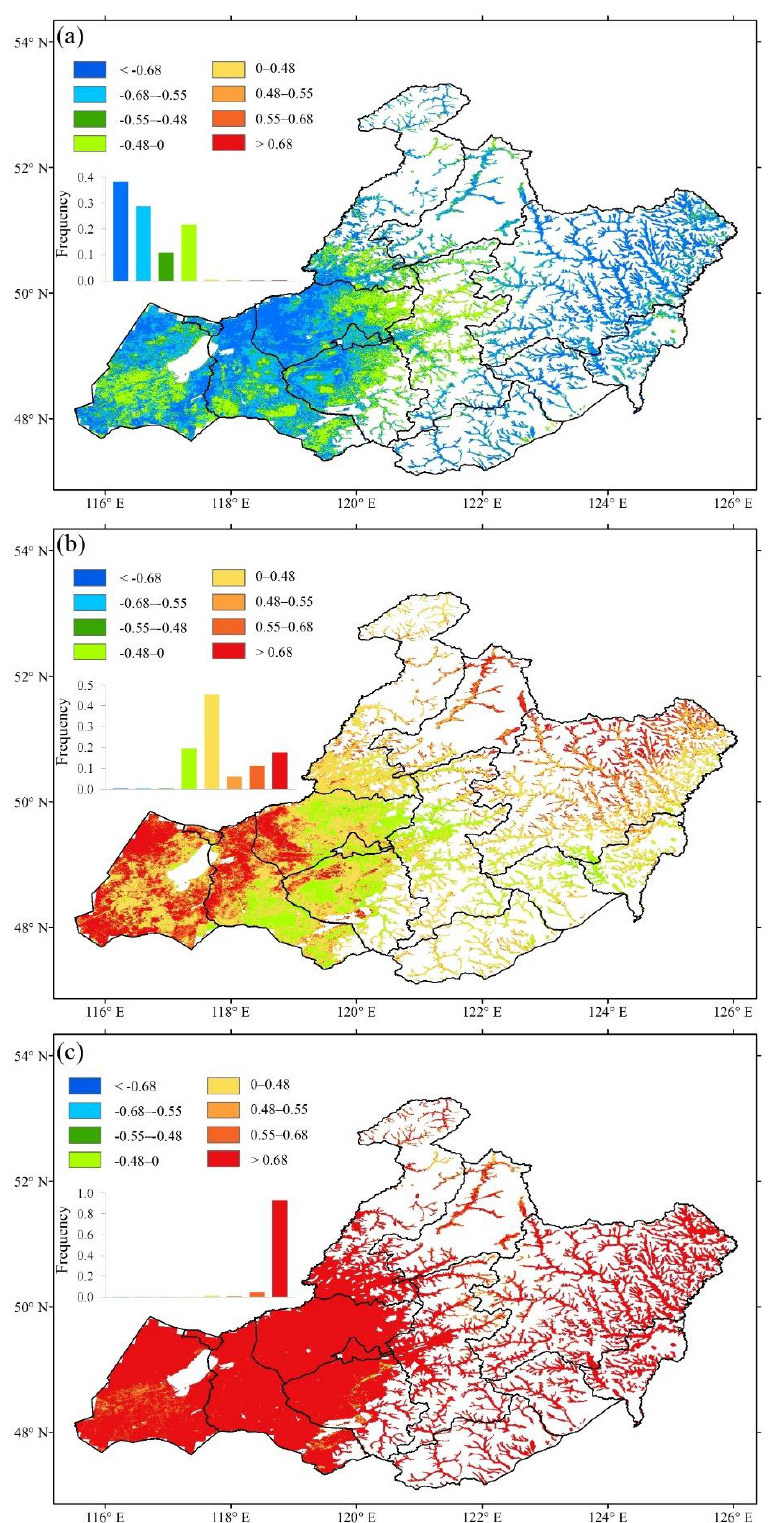
Figure 12. Spatial patterns of the interannual partial correlations between the accumulated growing degree-days requirement and chilling days ( a ), precipitation ( b ), and insolation ( c ). Partial correlation coefficient values of ±0.68, ±0.55, and ±0.48 correspond to significance at p = 0.01, p = 0.05, and p = 0.10, respectively. Top-left insets show the frequency distributions of the correlation coefficients corresponding to values indicated by the map legends.